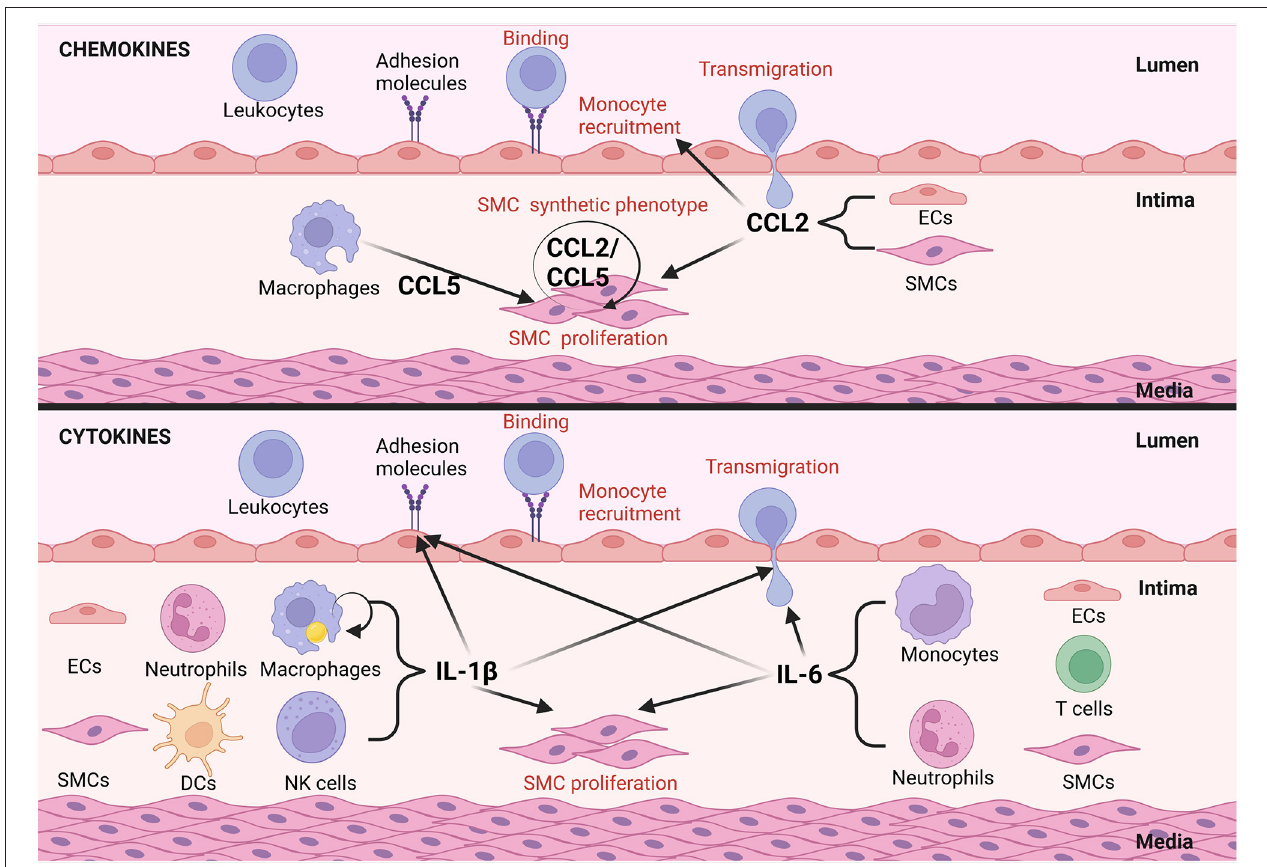
FIGURE 2 | Examples of autocrine/paracrine interactions of inflammatory mediators in vascular remodeling in atherosclerosis. Inflammatory mediators can act in an autocrine manor, CCL2 and CCL5 for example activate VSMCs to undergo phenotypical changes in atherosclerosis. EC and VSMC derived CCL2 can further foster cross-talk between them promoting remodeling. CCL2 from ECs triggers synthetic differentiation of VSMCs and CCL2 from VSMCs promotes monocyte recruitment. Alternatively, mediators like interlukin-1 β , expressed by dendritic cells (DCs) and natural killer (NKs) cells promote the upregulation of adhesion molecule expression by ECs, transmigration of circulating leukocytes and VSMC proliferation in a paracrine fashion. IL-1 β in addition can act upon macrophages to promote IL-1 β secretion in an autocrine manner. IL-6 secreted by ECs, monocytes, T cells, neutrophils and VSMCs promotes adhesion molecule expression by ECs as well as transmigration of circulating immune cells into the atherosclerotic plaque (this figure was made with